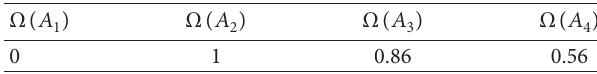
Table 13: Overall prospect dominance degrees.